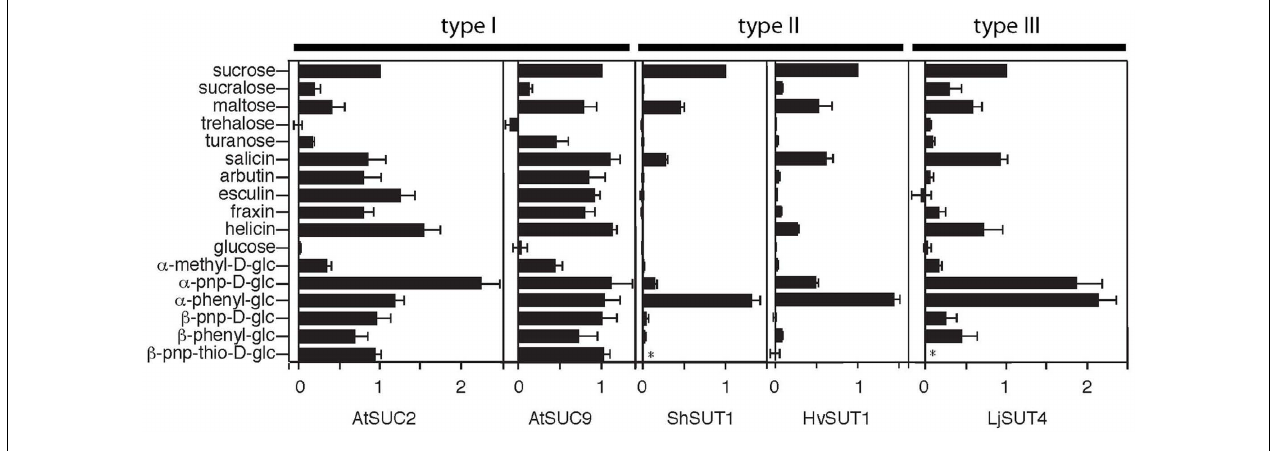
(depending on the transporter affinity and substrate solubility). All currents were normalized to sucrose-dependent currents and are presented as mean ± SE with at least three oocytes per mean. ∗ Indicates substrate not tested. Modified with permission from Chandran et al. (2003), Sivitz et al. (2005, 2007), Reinders et al. (2006,